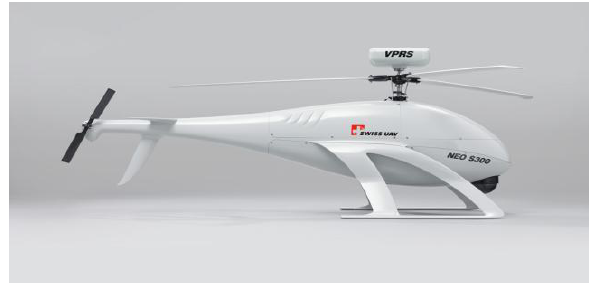
Figure 6 Test field in the countryside and overflying NEO platform (top left: close up of the test